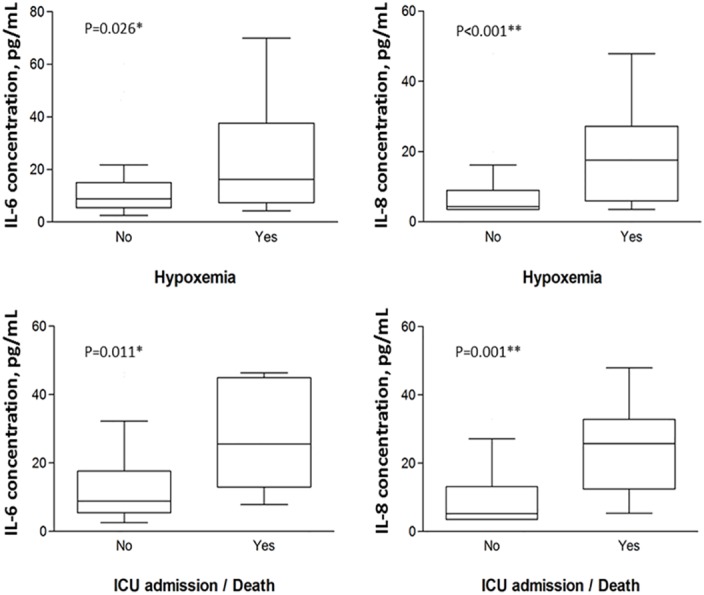
High plasma IL-6 and IL-8/CXCL8 concentrations were significantly associated with development of respiratory failure (hypoxemia, upper panels), and the adverse outcomes of ICU admission/death (lower panels) in patients with confirmed active PTB (n = 80).Note. Other cytokines, hypoxemia [yes vs no]: IL-18 [median (IQR), 1655.0 (1266.6–2185.8) vs 1516.3 (1285.8–1882.3) pg/mL]; sTNFR1 [median (IQR), 1460.2 (1054.1–2008.7) vs 1664.6 (1089.2–2571.4) pg/mL; HMGB1 [median(IQR), 3.5(2.1–5.2) vs 3.2 (1.7–4.5)], outliers excluded; all P >0.05.